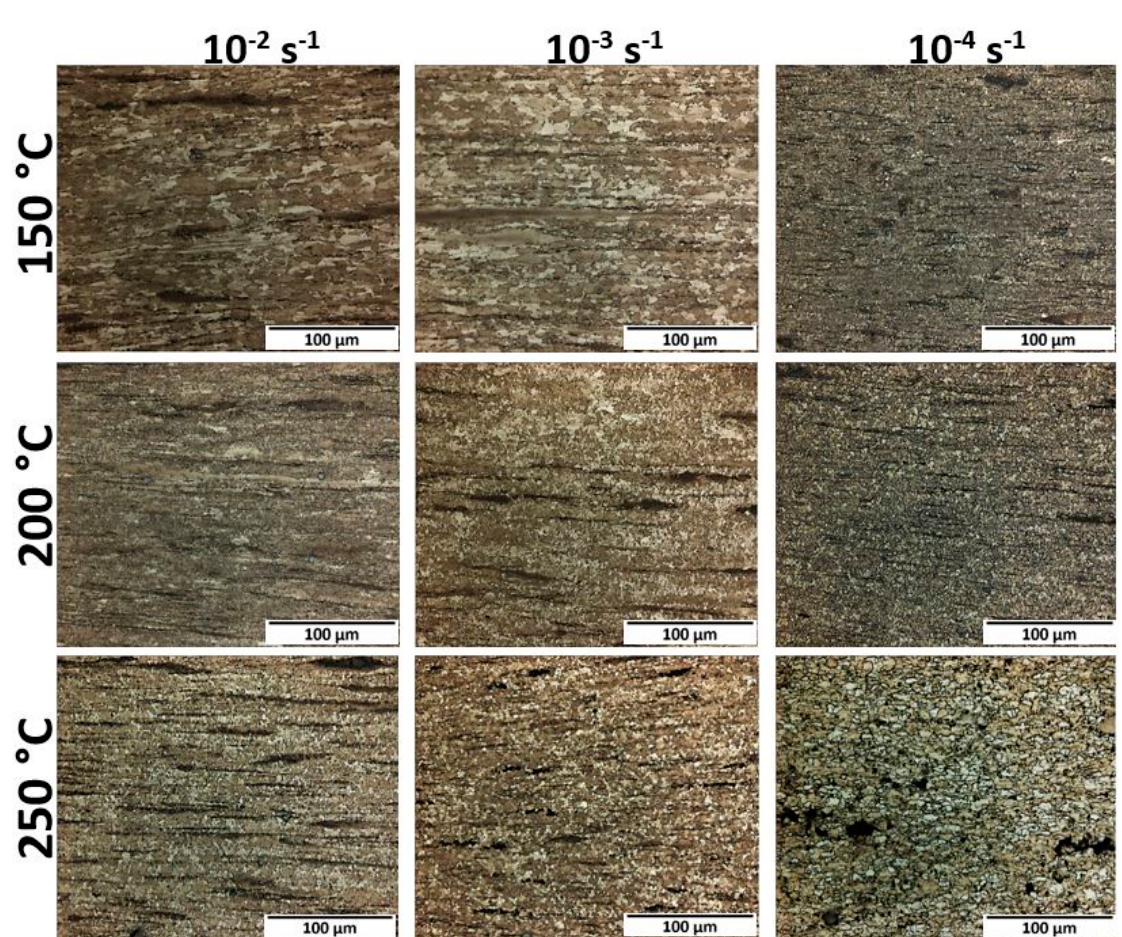
Figure 10. Microstructures obtained near the fractured zone after tensile tests at different temperatures and strain rates.